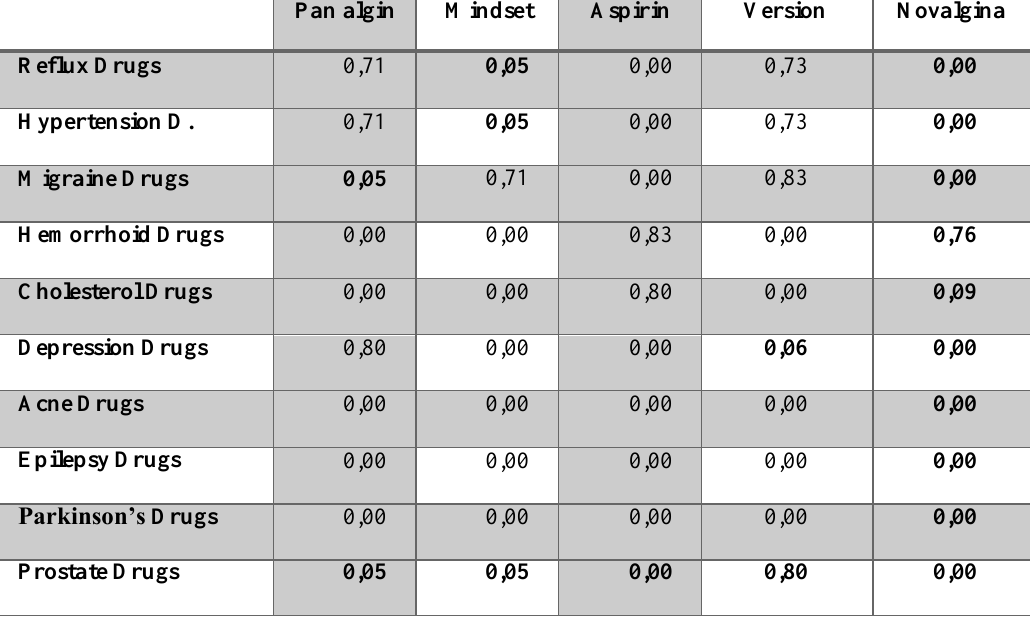
Table 5. The Estimated values for Painkiller Drugs Concerning Resource